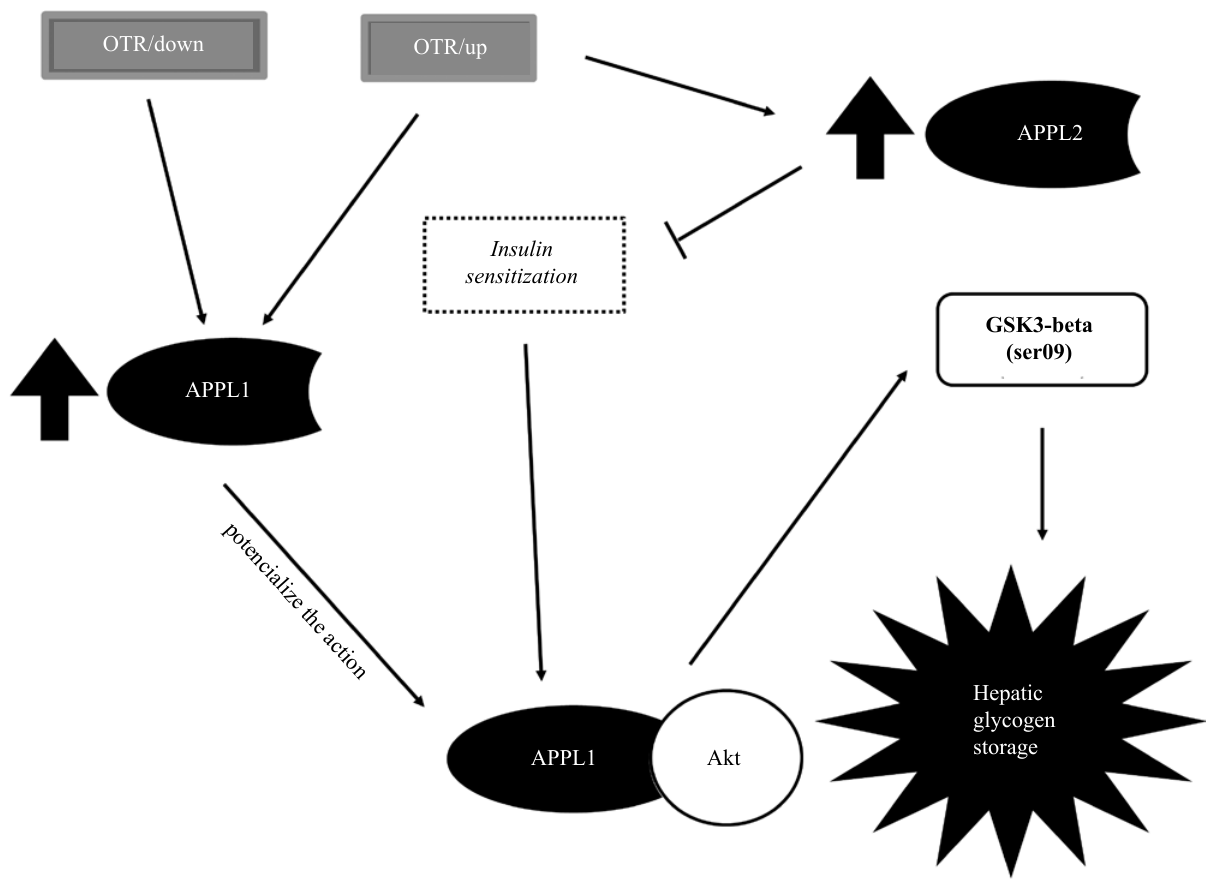
Figure 2. A squematic figure representing the possible mechanisms by which APPL1 and APPL2 act in the liver of overtrained mice. The over - training protocols based on downhill and uphill running upregulated the protein levels of APPL1, which can potentiate the action of Akt. The higher the activation of Akt, the higher is the phosphorylation and inactivation of GSK-3beta, activating glycogen synthase and increasing hepatic glycogen storage. The OTR/up group also upregulated APPL2, which may decrease insulin sensitization. It is important to highlight that the pro- tein levels of Akt and GSK-3beta, as well as the glycogen contents of the OTR/down, OTR/up and OTR groups, were recently published3 using the same liver samples as the current